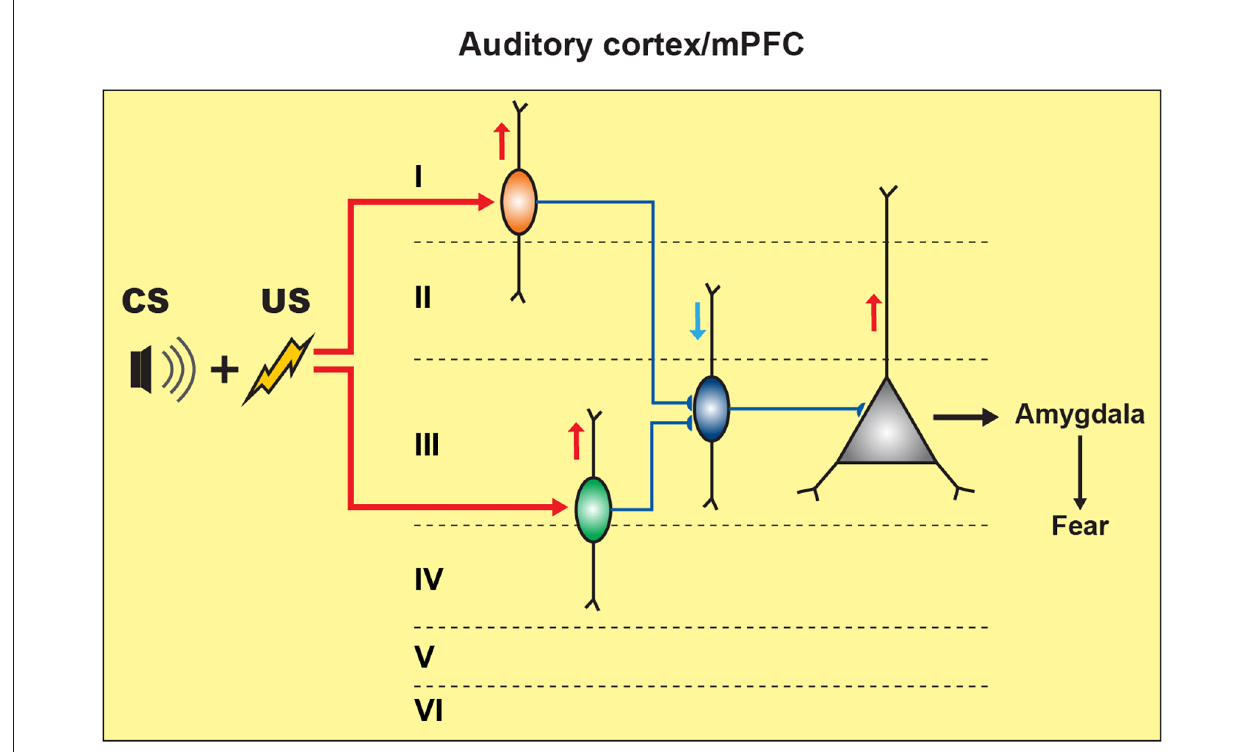
FIGURE3 Inhibitory and disinhibitory circuit motifs in neocortical regions support fear memory formation. In the auditory cortex (A1), CS-US pairing elicits fear memory encoding by activating the L1 inhibitory neuronal population (orange) that can cause the disinhibition of L2/3 PCs by restricting the PV+ cell (blue) perisomatic inhibitory input onto the PCs, resulting in fear response expression. In the mPFC, CS-US association activates the SOM+ cells (green) that cause the disinhibition of PCs by inhibiting the PV+ cells’ activity, resulting in fear